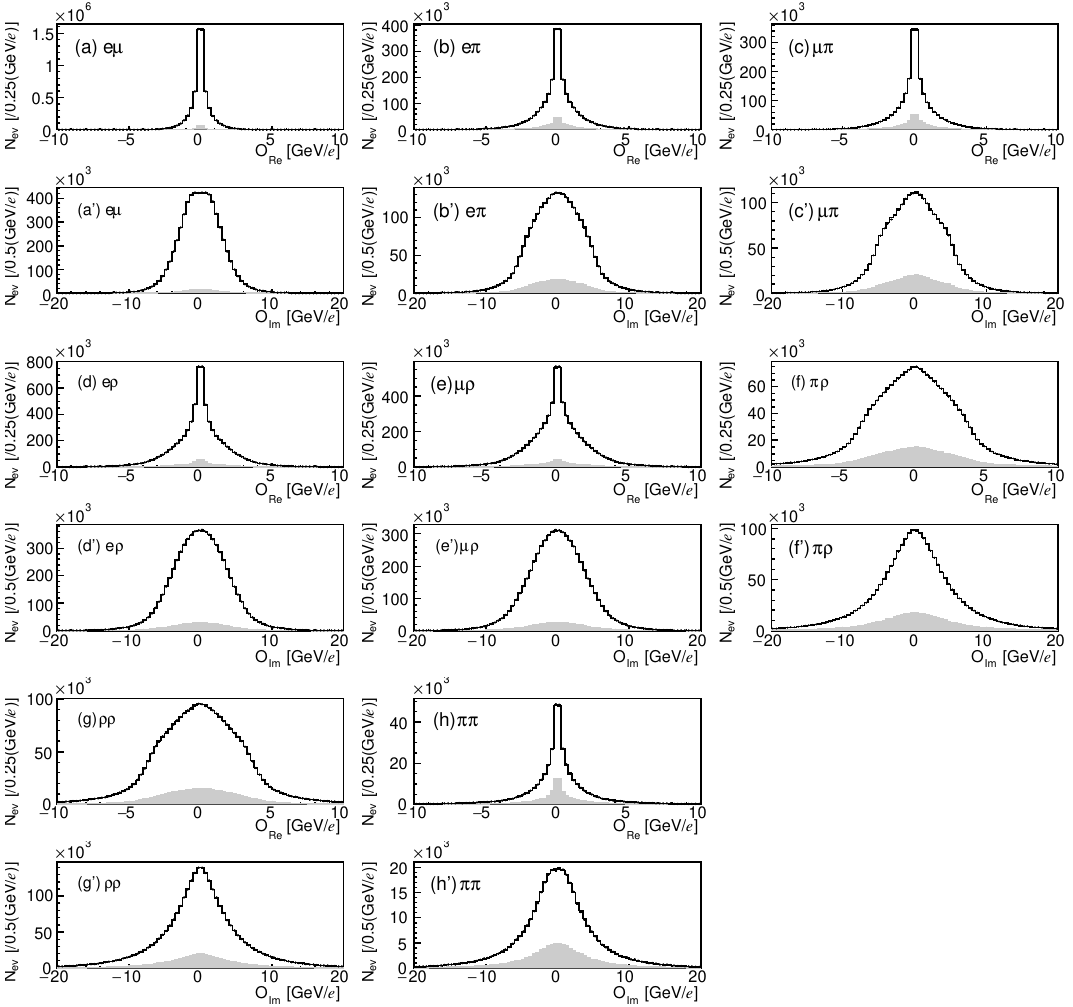
Figure 3 . Distributions of optimal observable for each mode. The upper (a)–(h) plots are O Re and the lower (a’)–(h’) plots are O Im for each mode. The points with error bars are the data and the solid histograms are the MC expectation with zero EDM. The gray shaded histograms are the background contribution estimated from